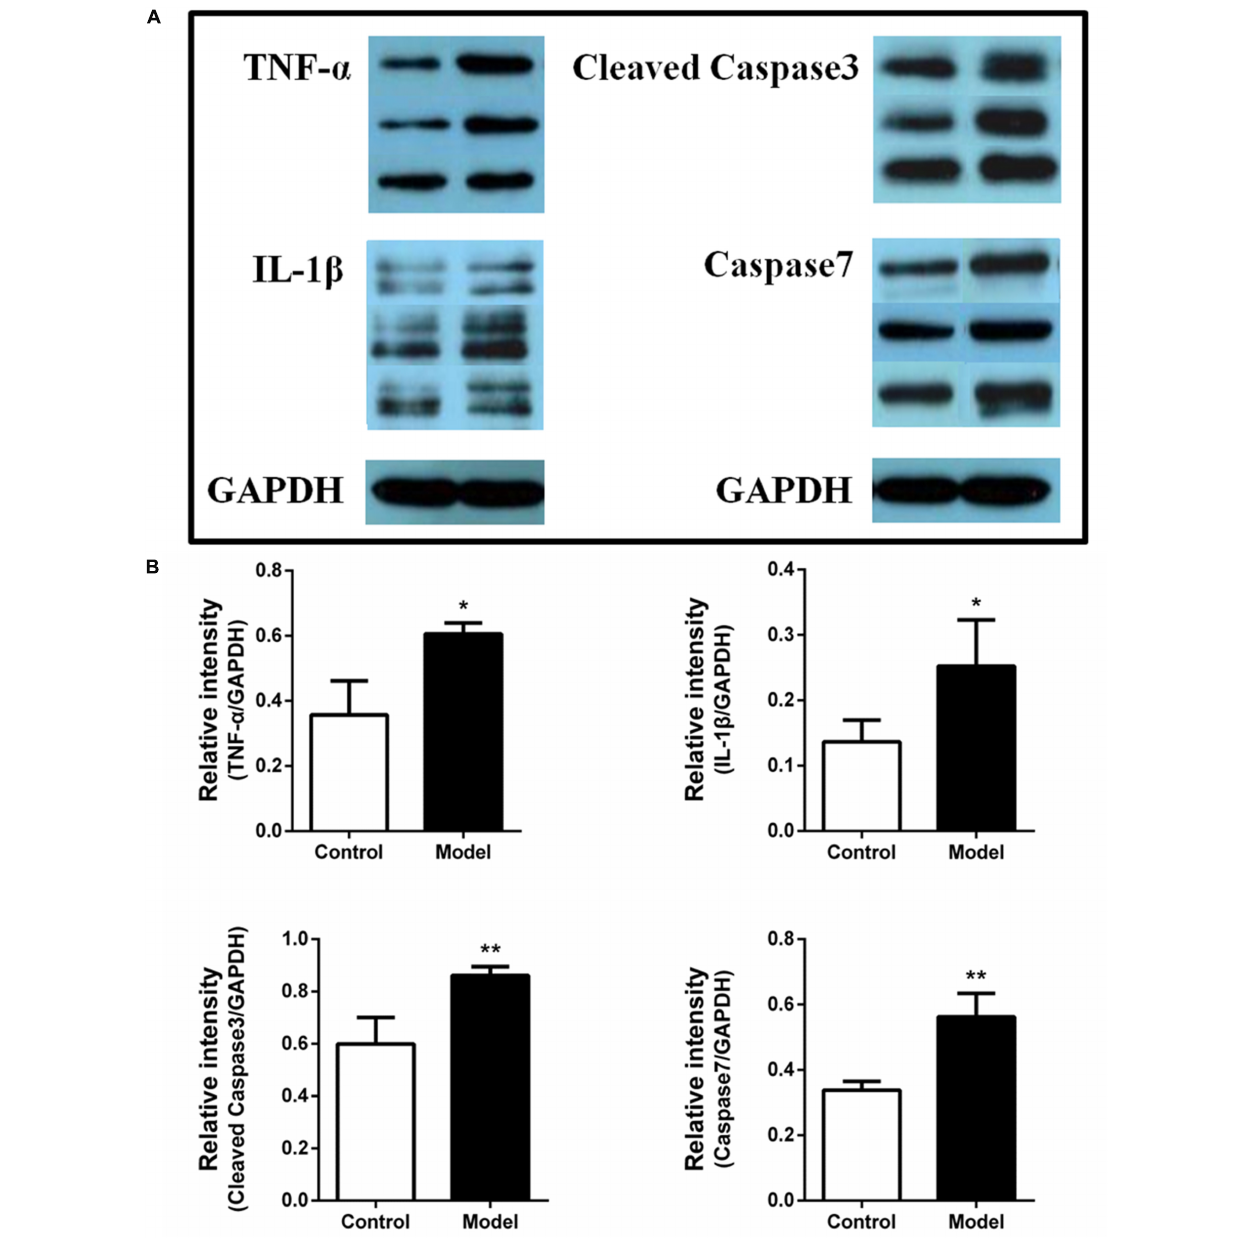
FIGURE 5 | Isoproterenol-induced AMI rats are accompanied by the over-expression of inflammatory factors and apoptotic proteins in ileum. (A) The protein expression bands of TNF- α , IL-1 β , cleaved caspase-3, and caspase-7 in ileum between the ISO-induced AMI group and model group. (B) The Bar graph of the over-expression of TNF- α , IL-1 β , cleaved caspase-3, and caspase-7 in ileum between the ISO-induced AMI group and model group. ∗ p < 0.05 versus the control group, ∗∗ p < 0.01 versus the control